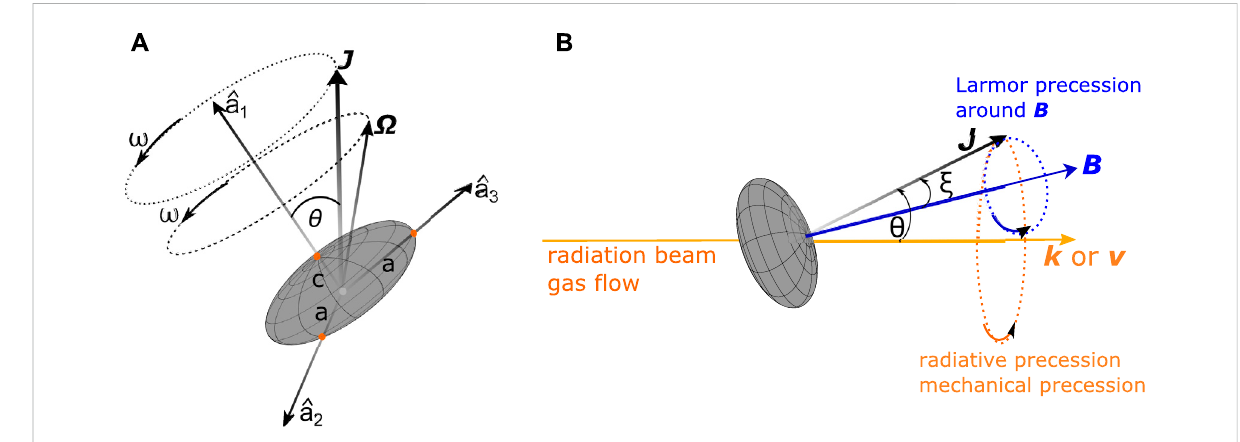
FIGURE 1 (A) Illustration of internal alignment between the angular momentum ( J ) and the short axis ( a 1 ). (B) Illustration of external alignment between J and the external magnetic fi eld ( B ) or radiation direction ( k )or gas fl ow ( v ). Ω is the angular velocity, and ω is the angular frequency. Figures are taken from Hoang T. et al.